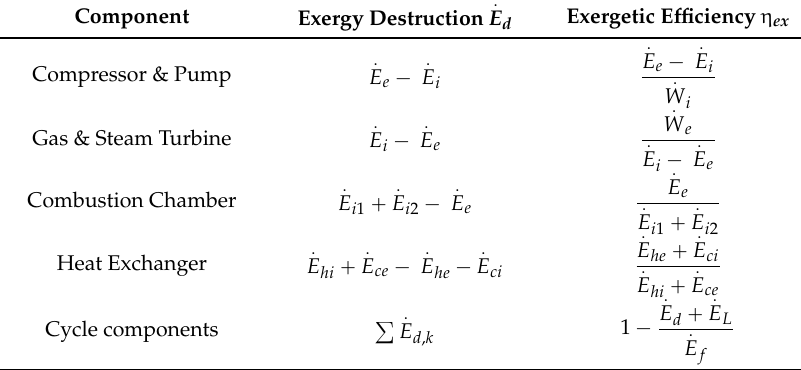
Table 3. Exergy destruction rate and exergetic efficiency for different component at steady state